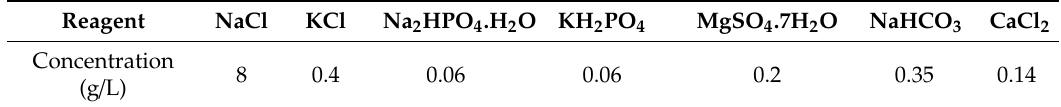
Table 2. Composition of Hanks’ solution used for immersion